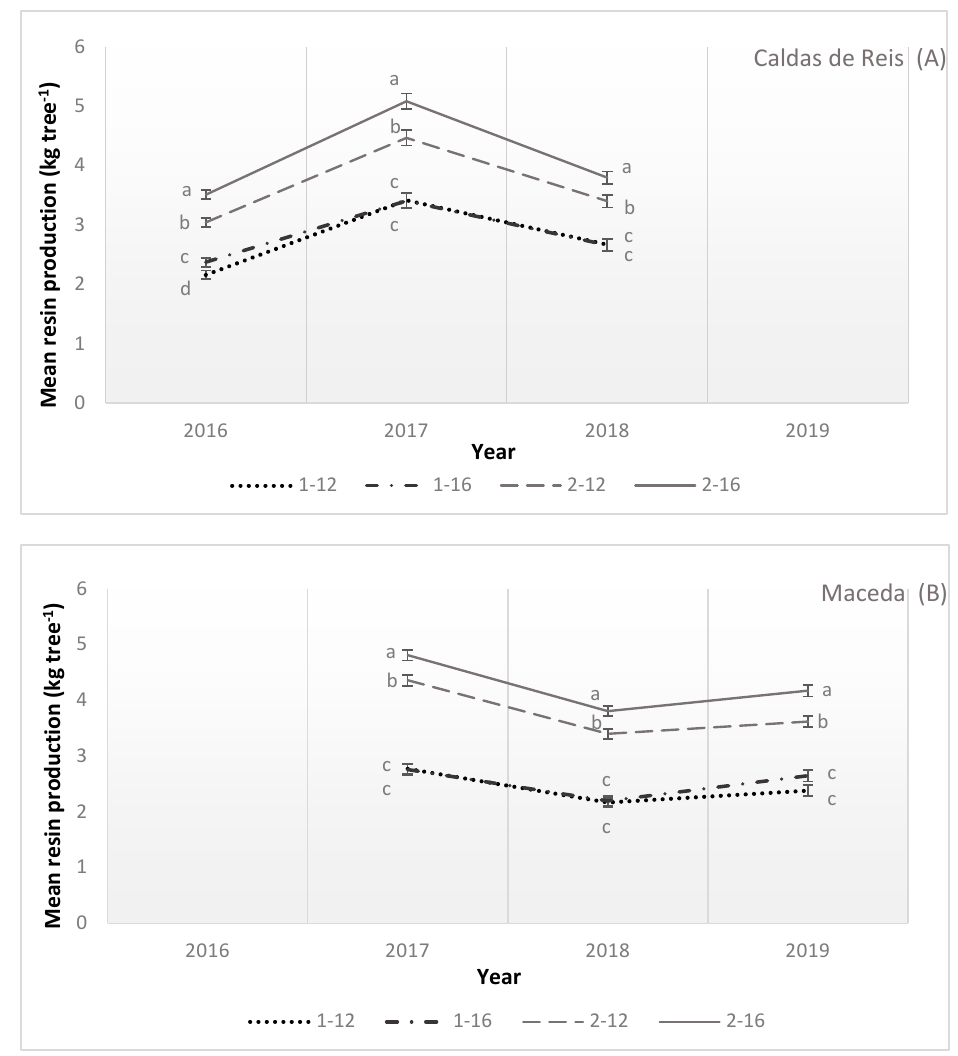
Figure 2. Mean resin production (kg tree − 1 ) from P. pinaster in each year in Caldas de Reis ( A ) and Maceda ( B ) for the four combinations of number of faces and wound width. 1–12: one face, 12 cm wound width; 1–16: one face, 16 cm wound width; 2–12: two opposing faces, 12 cm wound width; 2–16: two opposing faces, 16 cm wound width. Bars represent ± standard error. Different letters indicate significant differences between least squares means (LSM p < 0.05) for each location in a single season.